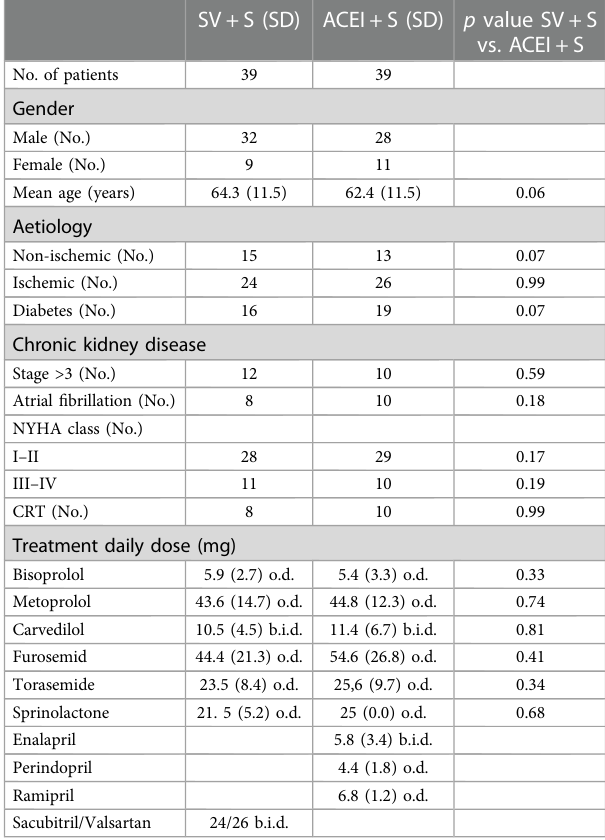
TABLE 1 Patients characteristics at baseline ( n